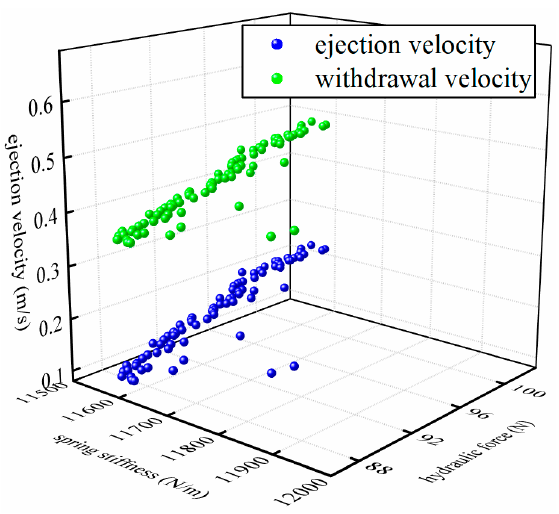
Figure 11. Pareto optimal solutions of spring stiffness, hydraulic pressure, impact velocity of ejection and withdrawal.